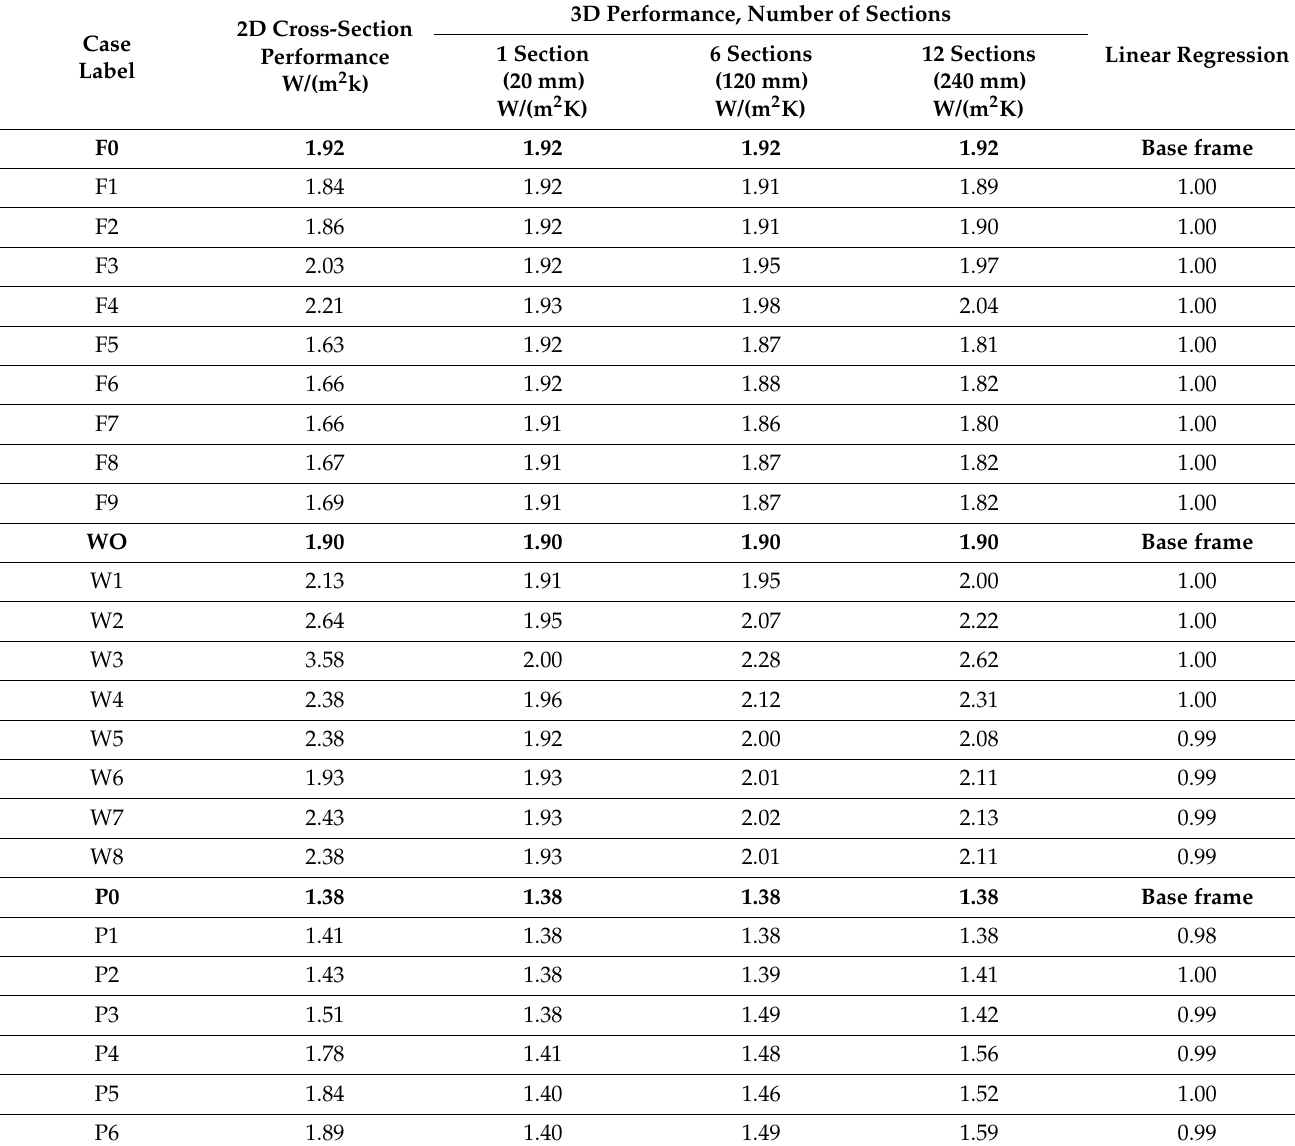
Figure 5. Example hardware configurations (marked with red) placed in a 600 mm long sill (30 sections) in three different lengths: ( a )—20 mm (1 section), ( b )—120 mm (6 sections), ( c )—240 mm (12 sections). Table 2. Thermal performance of base frames and hardware configurations with various lengths in a 600 mm long sill.